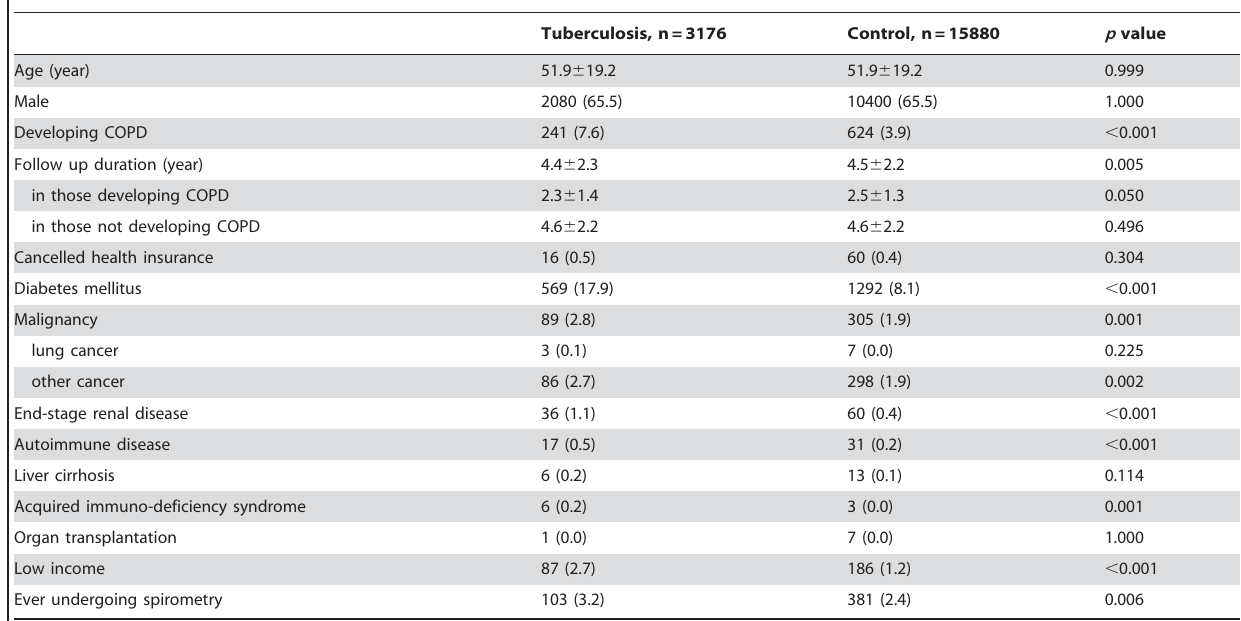
Table 1. Clinical characteristics of subjects at the initial study